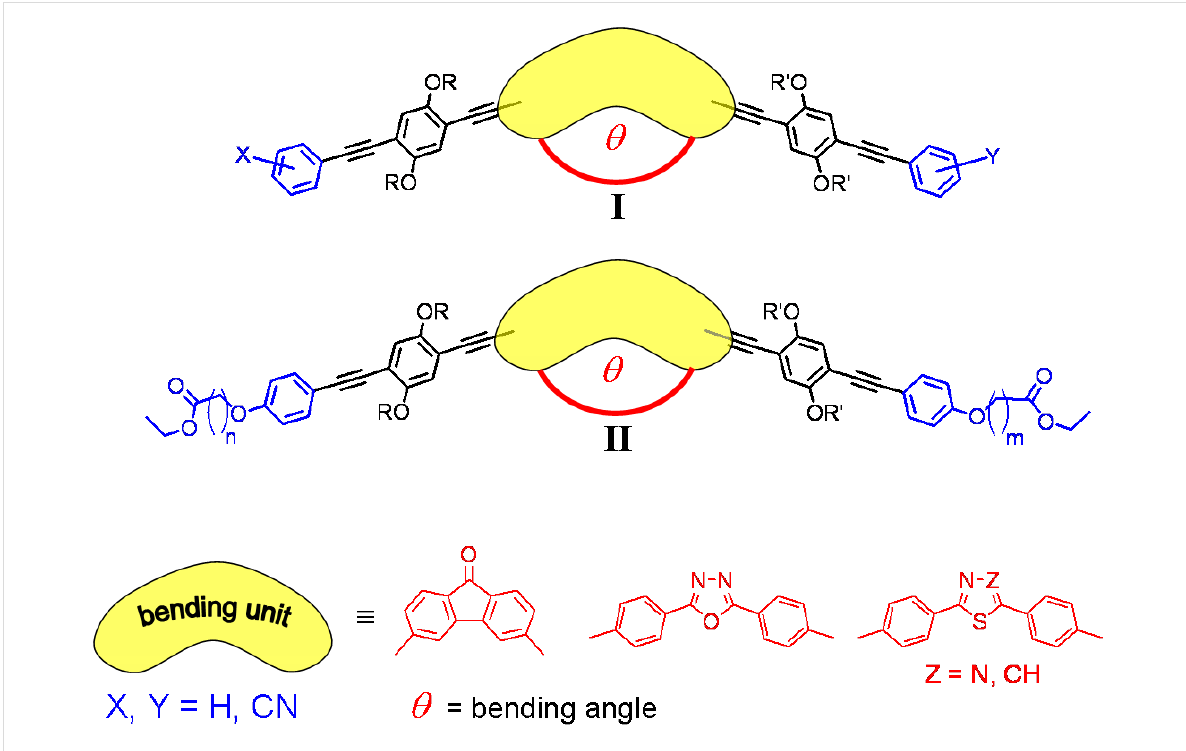
Figure 2: Design of V-shaped, shape-persistent oligo(phenylene ethynylene) mesogens of type I and II (R, R′ = alkyl chains; n, m = 4–10).